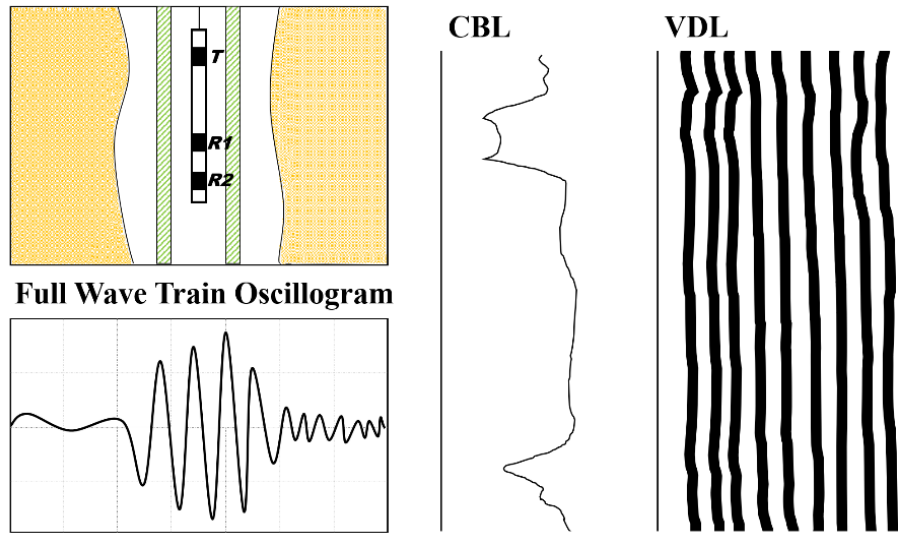
Figure 3. Waveform and CBL-VDL under the free casing. (2) The first interface and the second interface are well cemented.